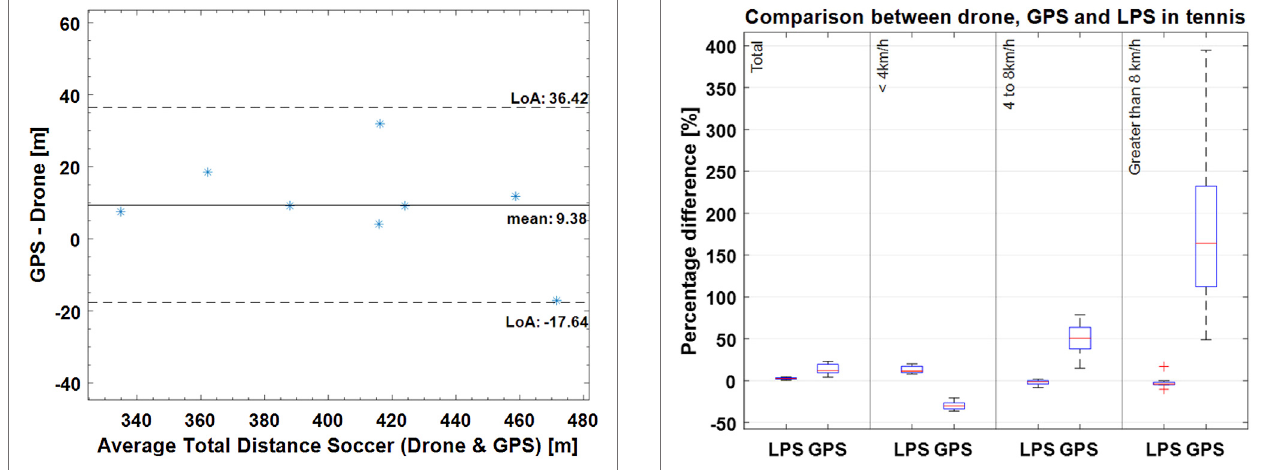
FIGURE 5 | Bland-Altman plot for the total distance covered in a small- sided game soccer match measured by the drone and GPS. Dashed lines showthelimitsofagreement(36.42 mand − 17.64 m),andthecontinuousline shows the mean (9.39 m).